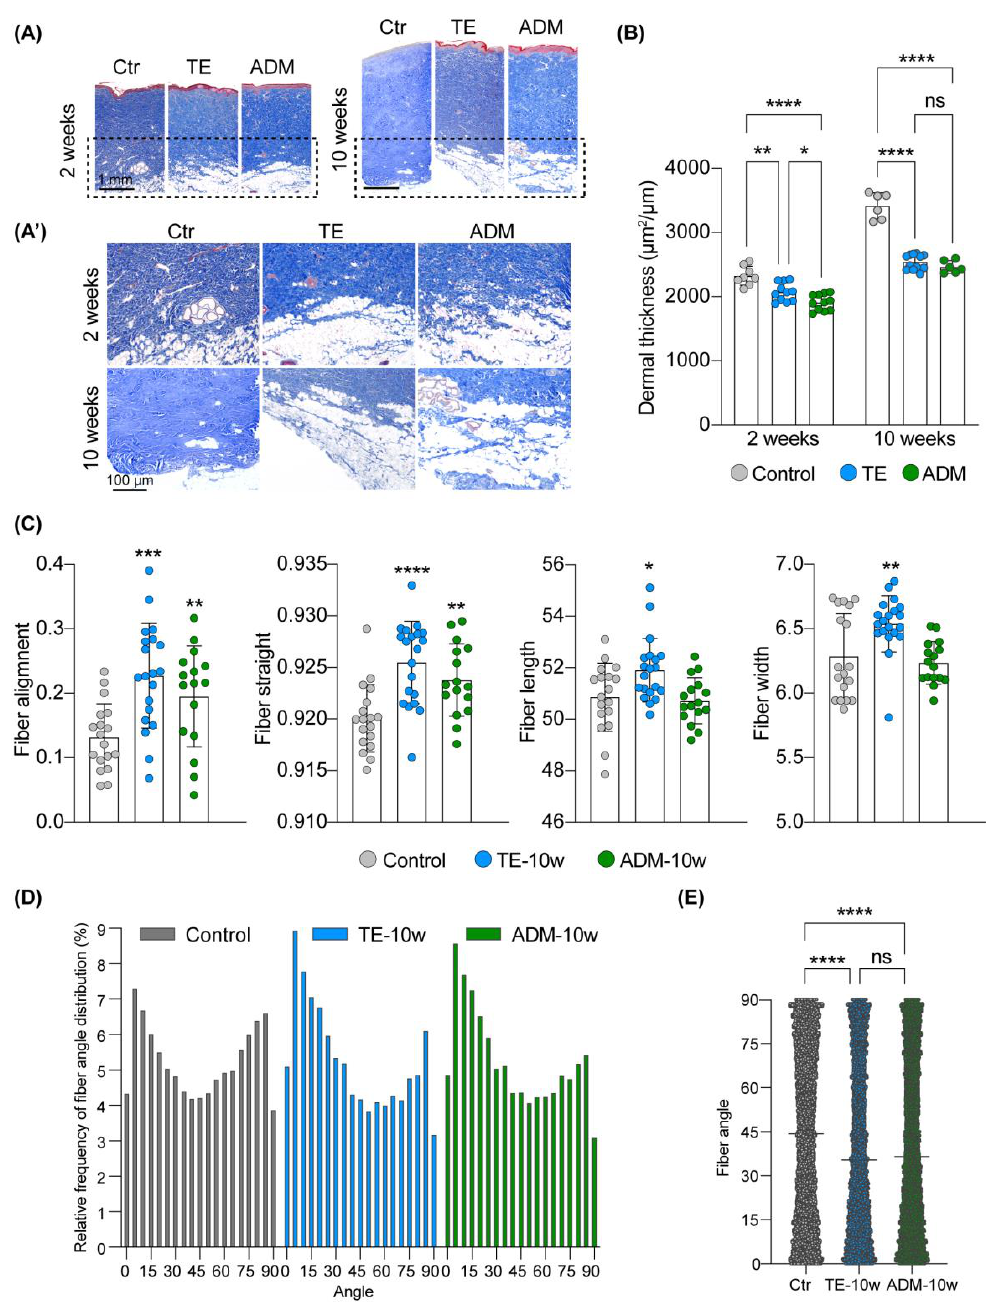
Figure 2. Biological cover limits structural changes in the dermis caused by mechanical stretching. ( A , A’ ) Representative images and ( B ) quantitative analysis of the dermal thickness of control (Ctr) and expanded skin (TE and ADM model) stained with trichrome at 2 and 10 weeks of expansion. Panel ( A’ ) presents the magnified views of the area marked in panel ( A ) (2× magnification). ( C ) Quantitative analysis of fiber organization in control (Ctr) and expanded skin (TE and ADM model) at 10 weeks of expansion on slides stained and analyzed with Picrosirius red and CT-FIRE, respectively. The values present the medians for each analyzed image and error bars represent SD. ( D ) Histogram and ( E ) bar graph of fiber angle distribution in the dermis of control (Ctr) and ex- panded skin (TE and ADM model) at 10 weeks of expansion, evaluated on Picrosirius red stained slides and analyzed with CT-FIRE software. The values present the averages for 9 images (3 images per biopsy) for each tested condition. Error bars represent SD. Statistical significance calculated in